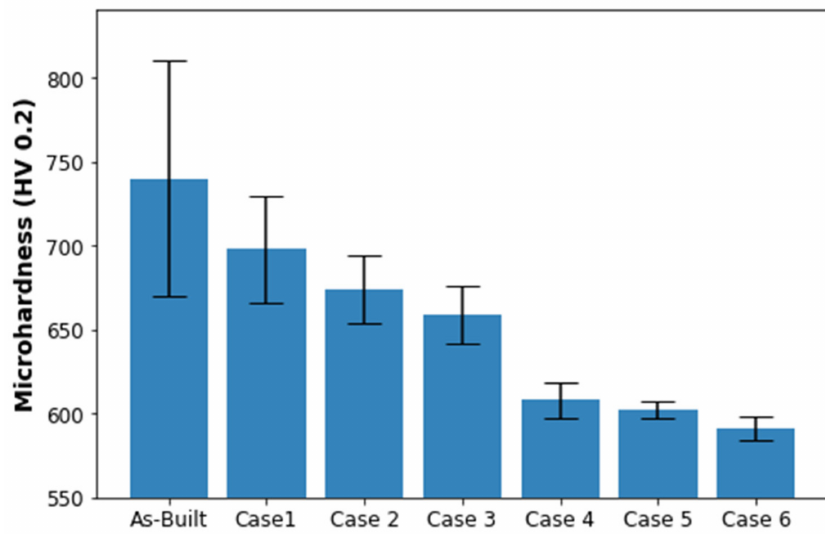
Figure 8. Average microhardness of the specimens on transverse